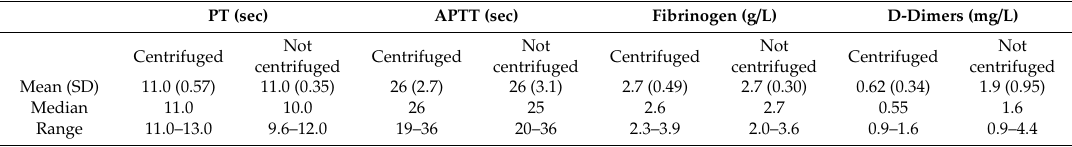
Table 1. Select parameters for di ff erent tests and collection